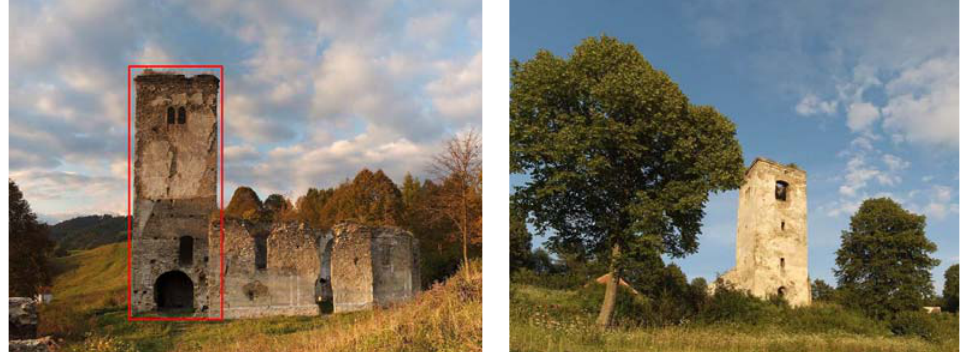
Figure 1. The examined Renaissance tower.